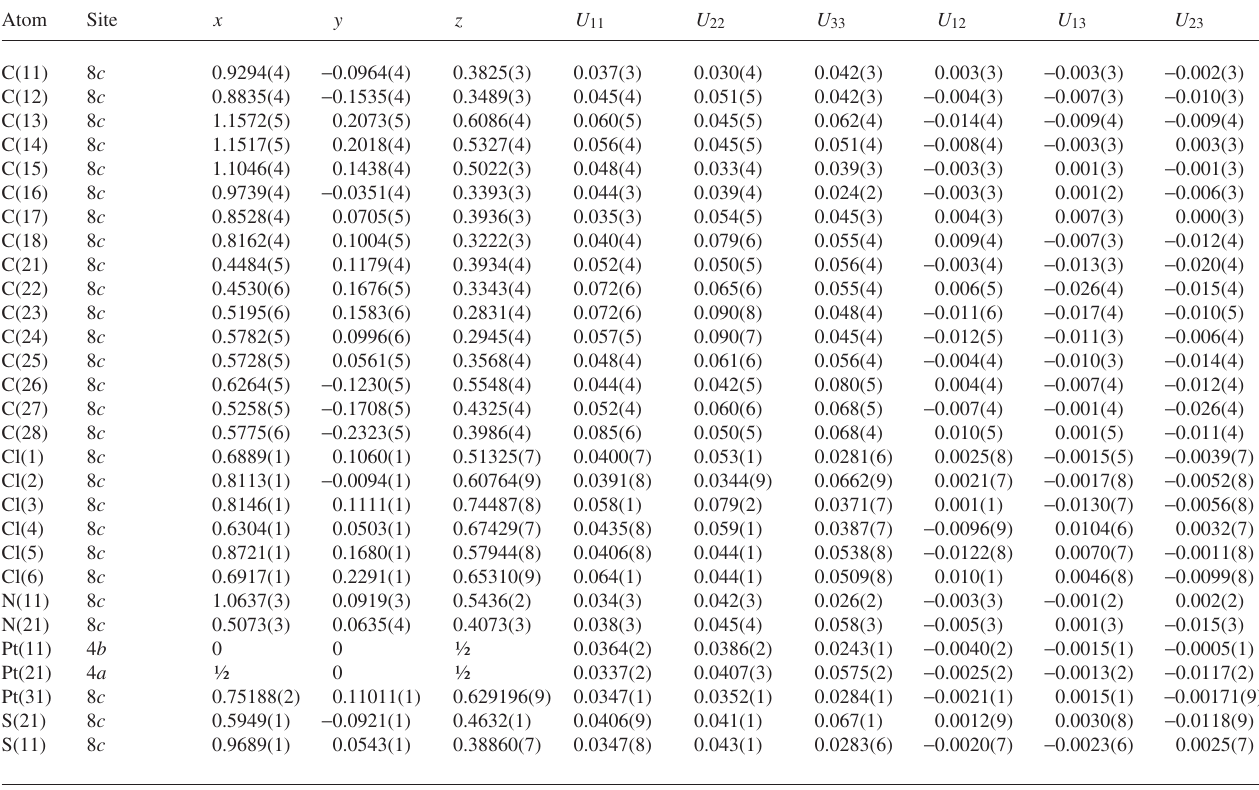
Table 3. Atomic coordinates and displacement parameters (in Å 2 ) .